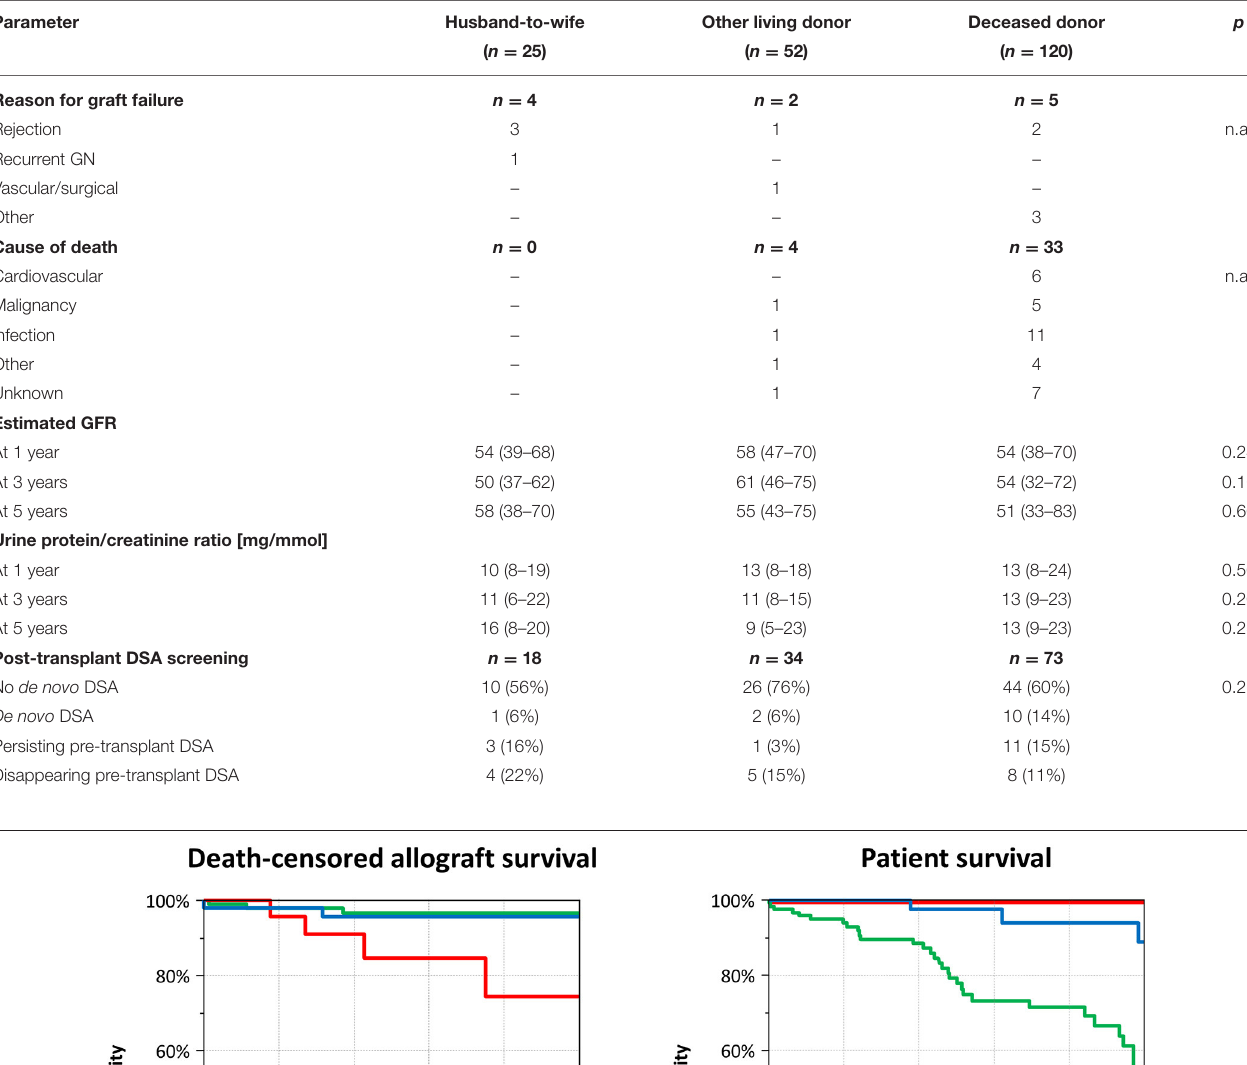
TABLE 2 | Major outcomes.